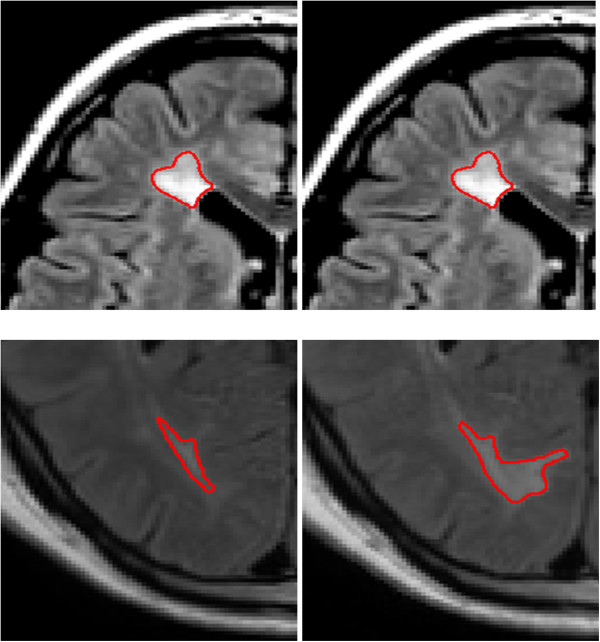
The left images are from a FLAIR MRI baseline scan of a patient with MS, and the right images are the matching planes at 3 month follow-up. MACC was used to propagate ROIs drawn of the lesions on the baseline scan to automatically create the ROIs on the follow-up scan. Since MACC creates the lesion ROIs based on the underlying image topography (in this case the follow-up scan), the automatically drawn follow-up ROIs accurately reflect both the changes in the size and shape of the lesion.